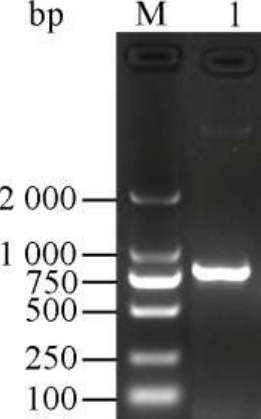
Forests 2018 , 9 , x FOR PEER REVIEW Figure 1. The electrophoresis results of the PCR products of the ChiKJ406136 gene PCR product M: DL2000 DNA Marker; 1: The PCR products of the ChiKJ406136 gene products.